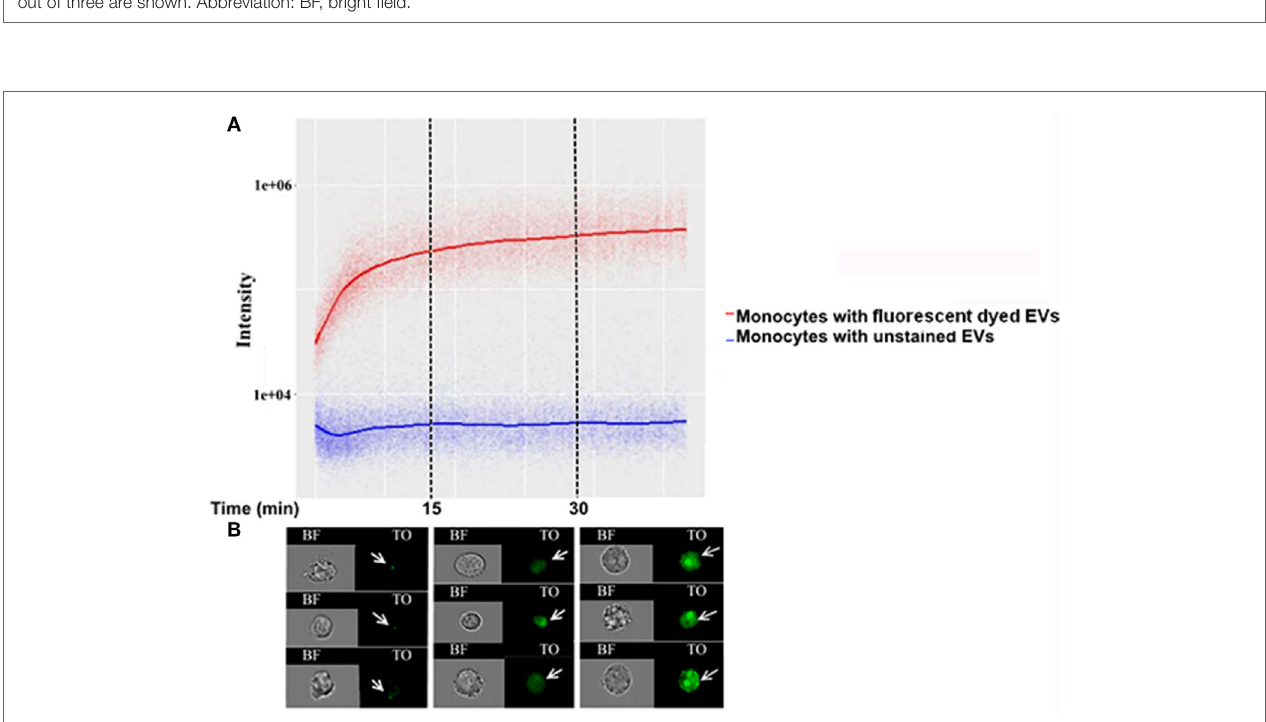
FIgURe 4 | Kinetics measurement of Plasmodium falciparum ( Pf )-extracellular vesicles (EV) uptake into monocytes using imaging flow cytometry (IFC). Pf -derived EVs were labeled by thiazole orange (TO), and their uptake into THP-1 cells was measured for 45 min. (A) Graph representing the signal modification in TO intensity that was detected over time originating from monocyte recipient cells. Representative results from three independent experiments are shown. (B) Signal detected by IFC from three representative recipient cells from each of the three time groups. Within the first 15 min, the EV signal appears as clear spots inside the cells (I), followed by the signal spreading inside the cell area for up to 30 min from EV internalization (II–III).